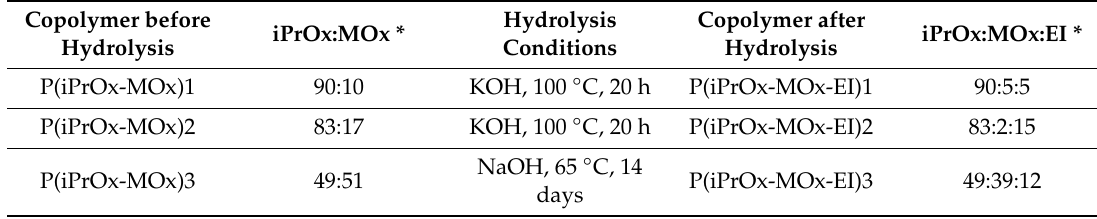
Table 3. The composition of copolymers obtained after hydrolysis.